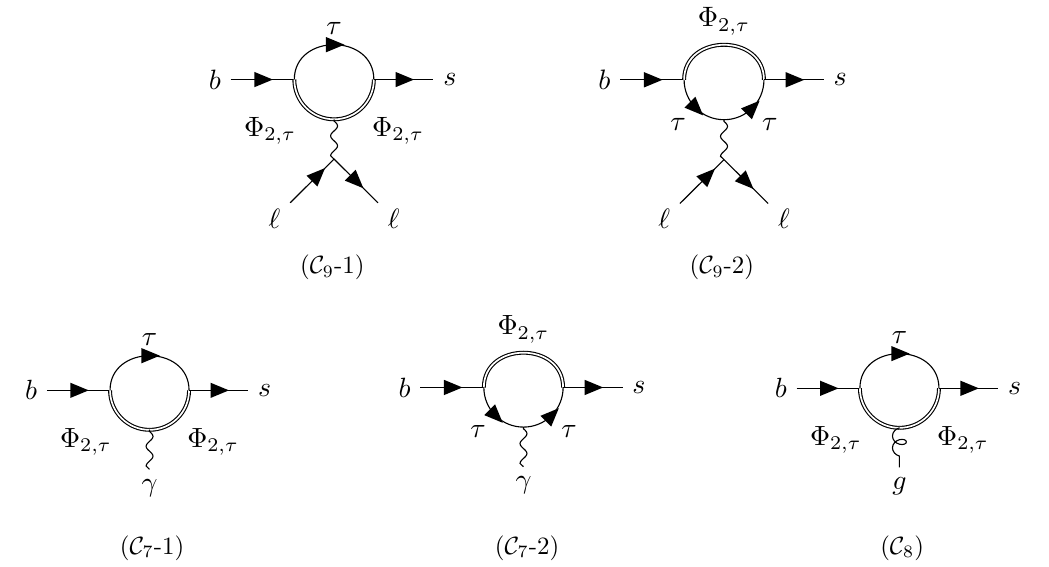
Figure 1. Feynman diagrams depicting the one-loop contributions of Φ 2 ,τ to the Wilson coefficients ( C ) , ( C ) and ( C ) , that play an important role in the global fit to b → s‘ + ‘ − 9 7 8 bs‘‘ bs bs